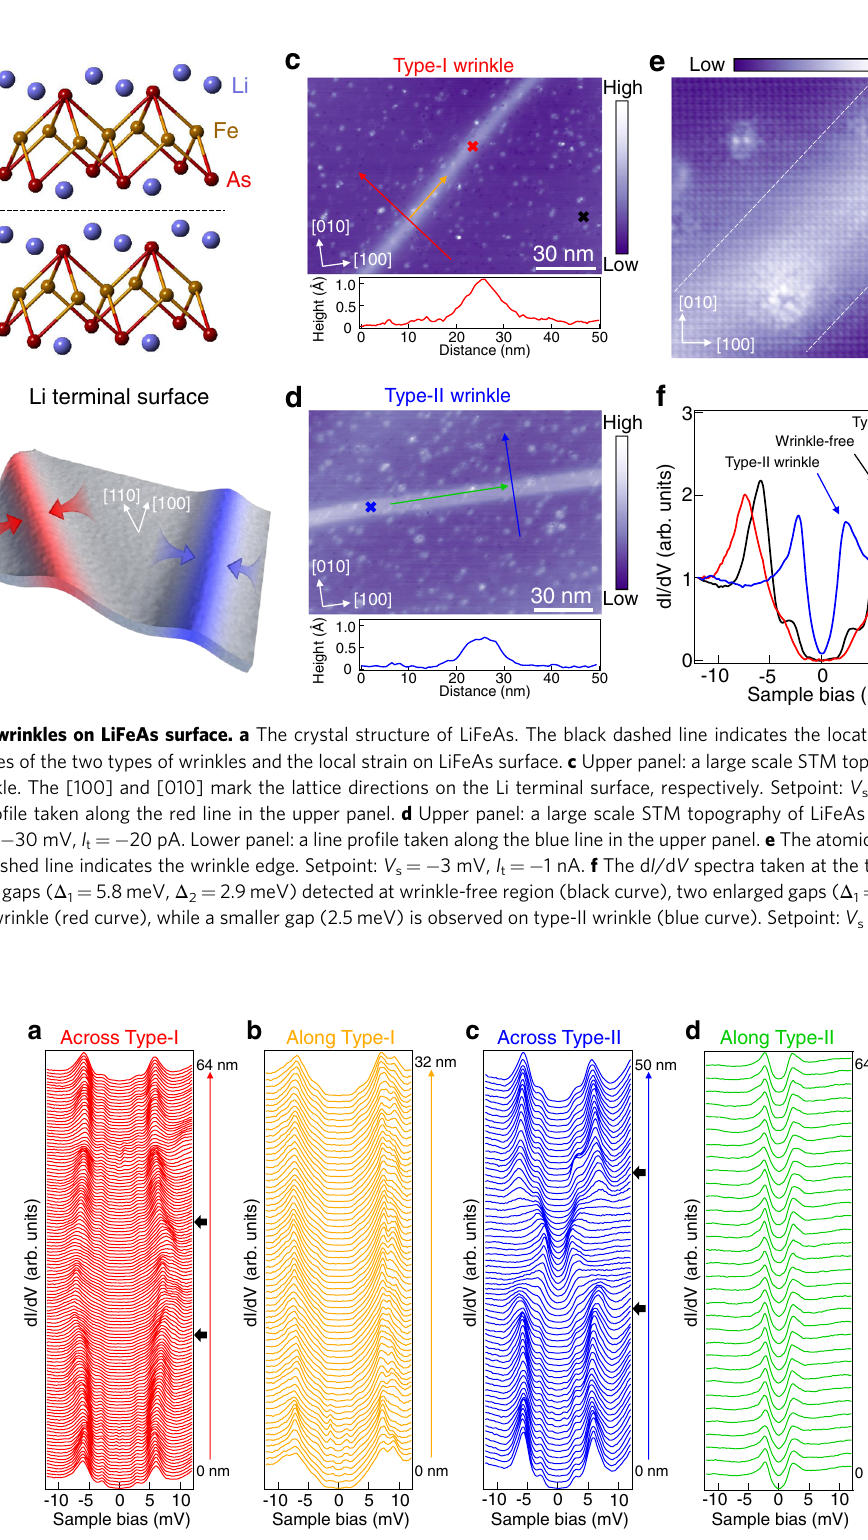
Fig. 2 Superconducting gaps on type-I and type-II wrinkles. a , b The waterfall plots of d I /d V spectra across (red) and along (orange) the type-I wrinkle as marked by the arrows in Fig. 1c, showing the homogeneous and enlarged superconducting gap along type-I wrinkle. The black arrows in ( a ) indicate the type-I wrinkle boundary. c , d The waterfall plots of d I /d V spectra across (blue) and along (green) the type-II wrinkle as marked by the arrows in Fig. 1d, showing the homogeneous and reduced superconducting gap along type-II wrinkle. The black arrows in ( c ) indicate the type-II wrinkle boundary. Setpoint for ( a – d ): V s = − 10 mV, I t = − 200